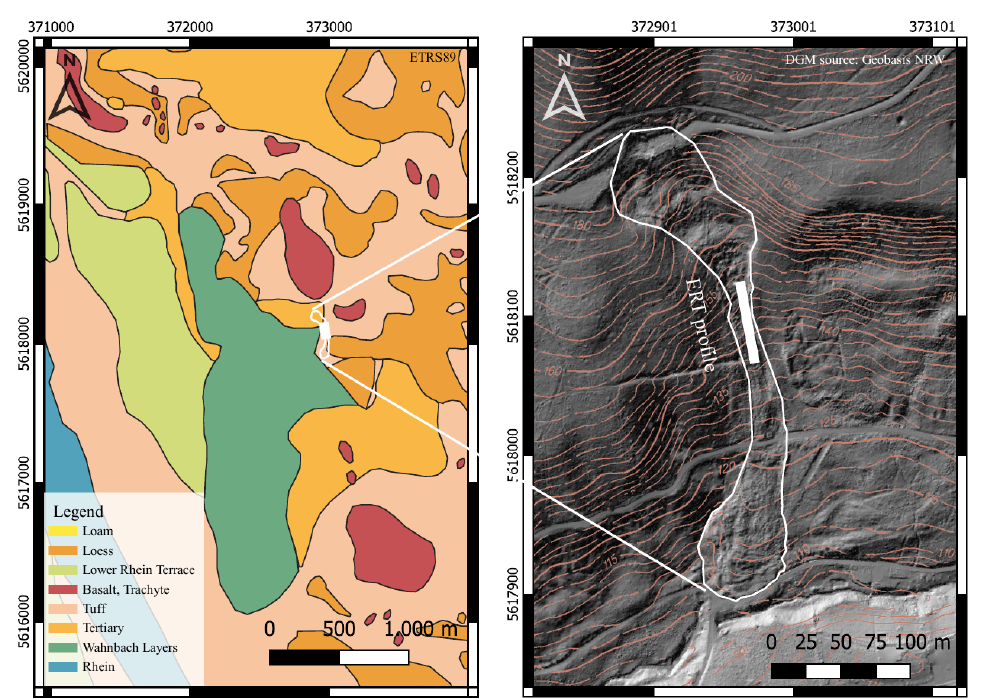
Figure 1. The left map shows a geological map of Dollendorfer Hardt region [46]. The landslide is framed with white on both maps. The right map shows the DEM of the landslide with contour lines for the height above sea level. The ERT profile in the transport zone of the landslide is marked with a white